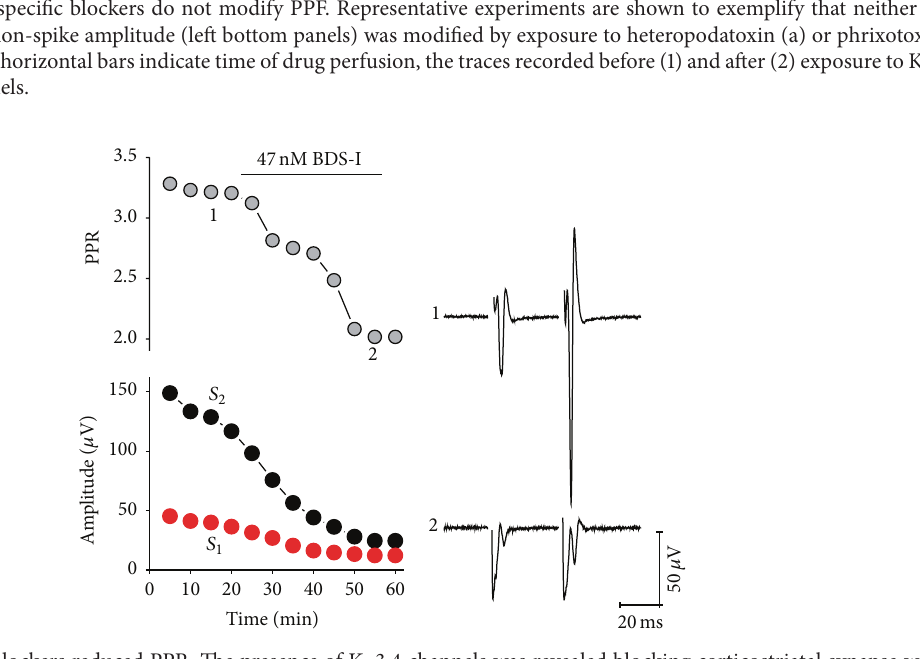
Figure 3: K V 3.4 channel blockers reduced PPR. The presence of K V 3.4 channels was revealed blocking corticostriatal synapse with BDS-1 (47 nM). Left superior panel shows time course of PPR of the experiment, and left bottom shows the time course of amplitudes of both 𝑆 1 and 𝑆 2 synaptic response. Right panel shows representative recordings indicated in left